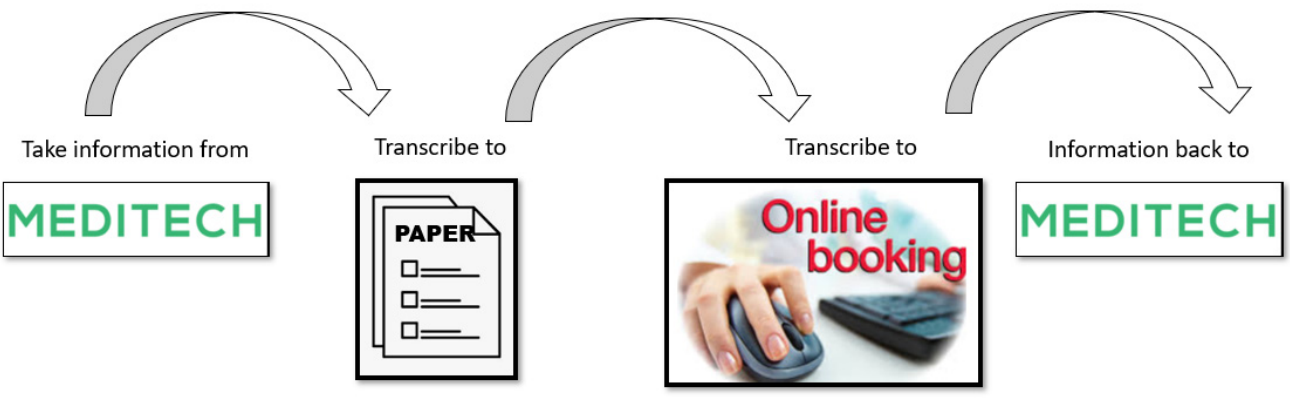
Figure 5. Duplication of work.